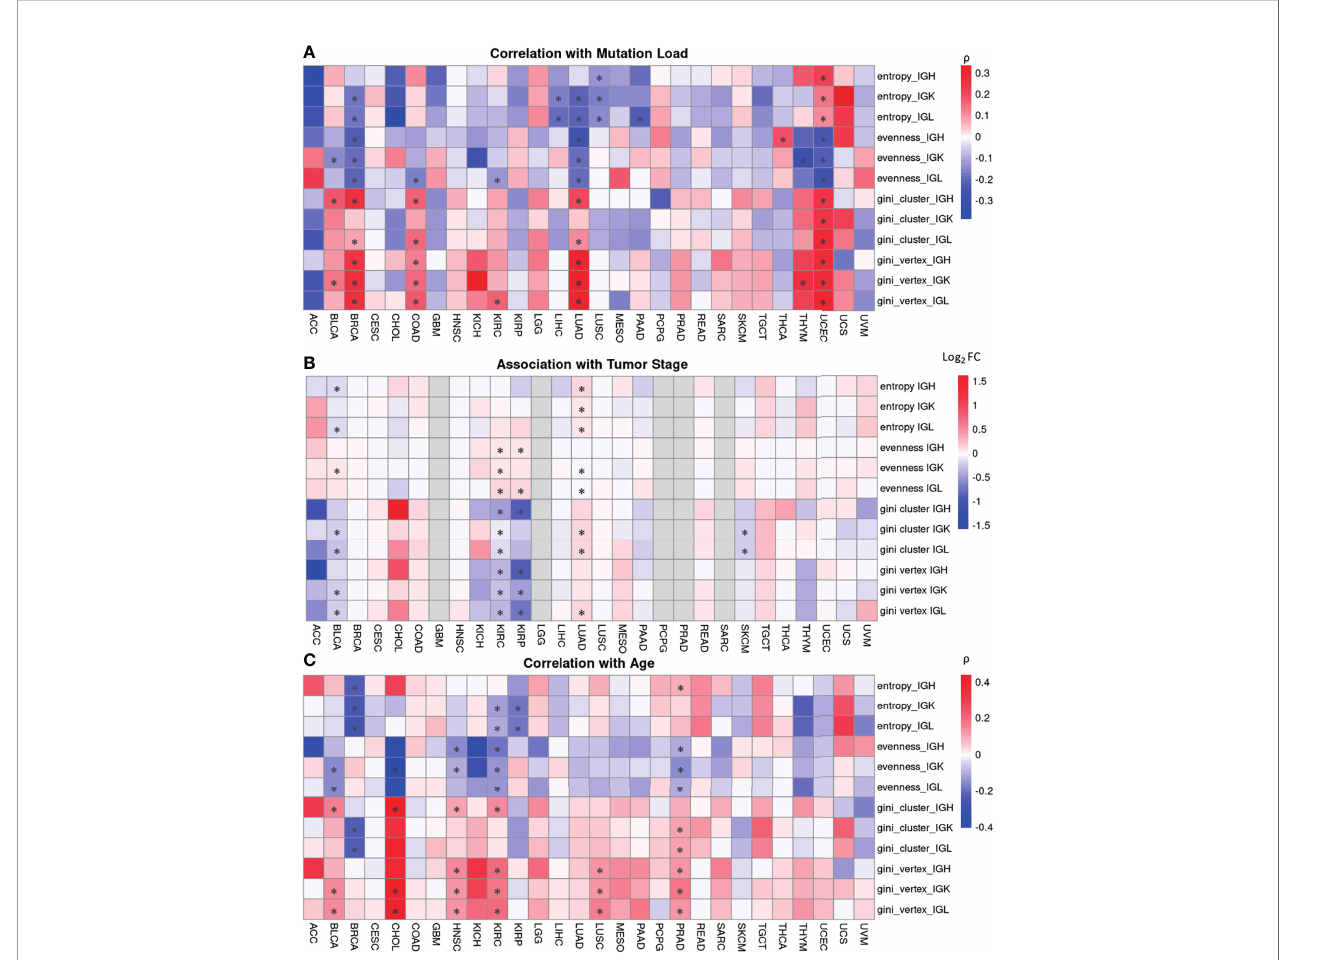
FIGURE 5 | Associations between B cell repertoire features and tumor and clinical characteristics. (A) A heatmap depicting Spearman ’ s correlation coef fi cient for mutation load, which is the number of non-silent mutations per megabase, and each B cell repertoire feature. Signi fi cant correlations (FDR < 0.05) are marked by an asterisk. (B) A heatmap showing the log2 fold ratio between the mean of the stage I-II tumors and the mean of the stage III-IV tumors. Signi fi cance was computing using the Wilcoxon rank-sum test and the asterisks indicate an FDR < 0.05. (C) A heatmap depicting Spearman ’ s correlation coef fi cient between patient ’ s age at diagnosis and each B cell repertoire feature. Signi fi cant correlations (FDR < 0.05) are marked by an